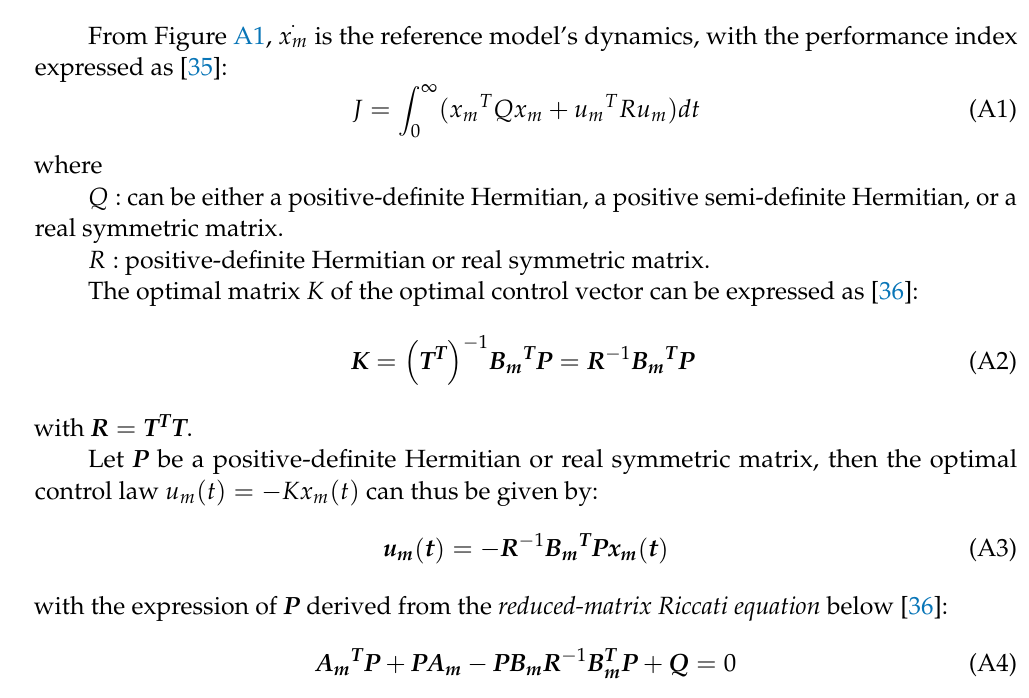
Figure A1. Optimal